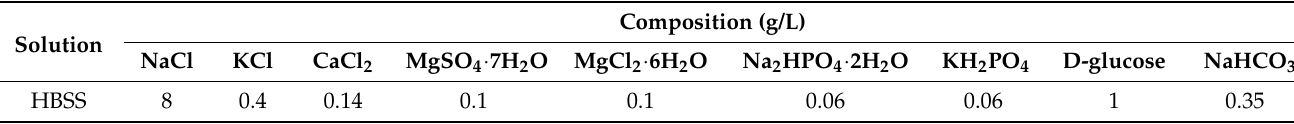
Table 3. Chemical composition of HBSS at pH =